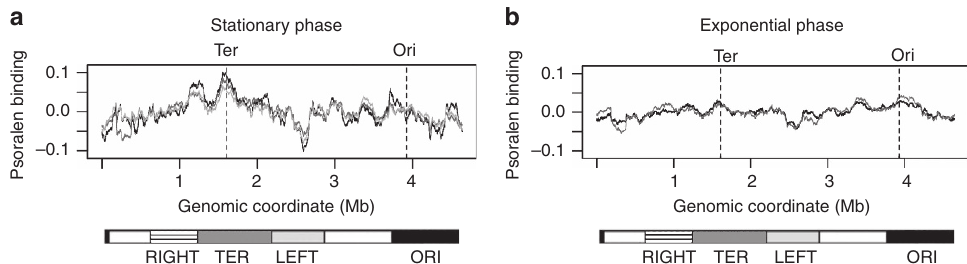
Figure 1 | Supercoiling patterns across the E. coli chromosome. ( a ) Psoralen binding in stationary phase. Black, dark grey and light grey tracks represent three independent replicates. The moving average of the signal is plotted with a window size of 200Kb. Dashed lines mark the positions of the terminus and origin of replication. Lower bars represent chromosomal macrodomains 54 . ( b ) Psoralen binding in mid-exponential phase. Black and grey tracks represent two independent replicates. Dashed lines mark the positions of the terminus and origin of replication. Lower bars represent